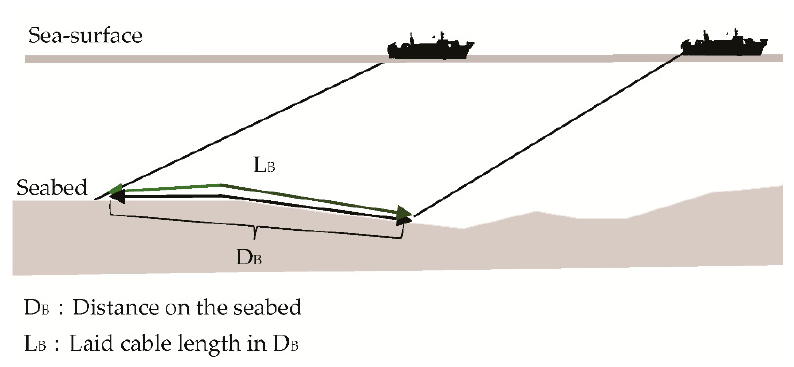
Figure 7. Conceptual diagram of seabed slack.